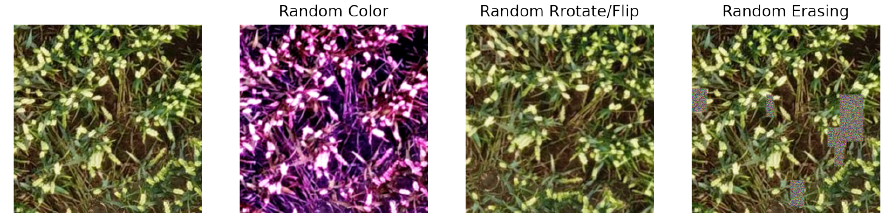
Figure 4. Image augmentations demonstration.